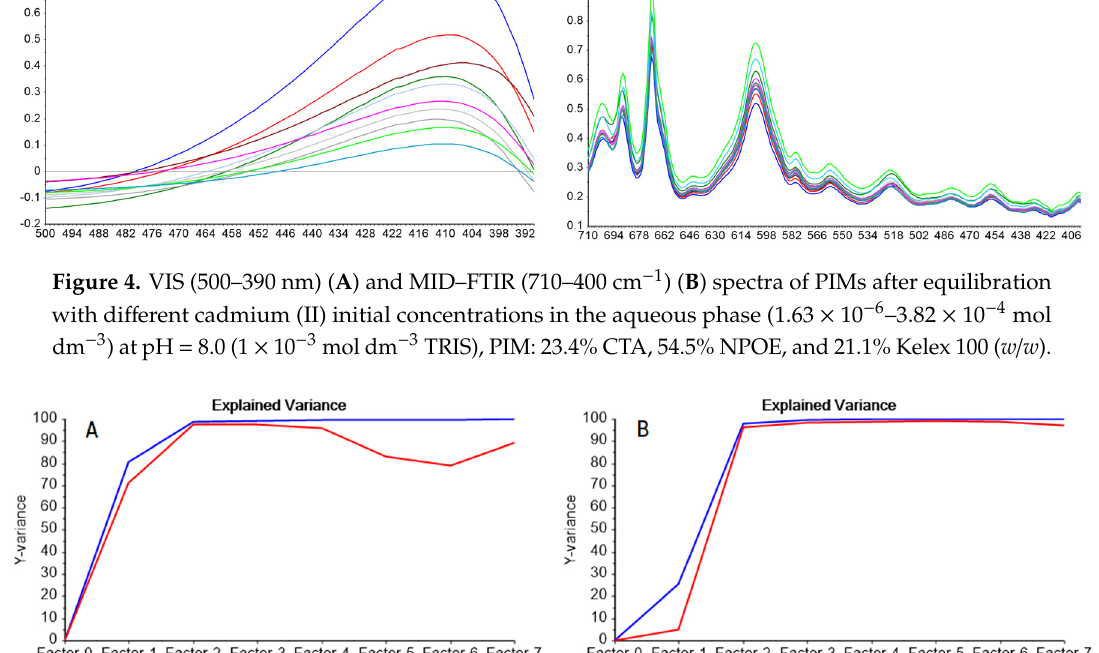
Figure 4. VIS (500–390 nm) ( A ) and MID–FTIR (710–400 cm − 1 ) ( B ) spectra of PIMs after equilibration with different cadmium (II) initial concentrations in the aqueous phase (1.63 × 10 − 6 –3.82 × 10 − 4 mol